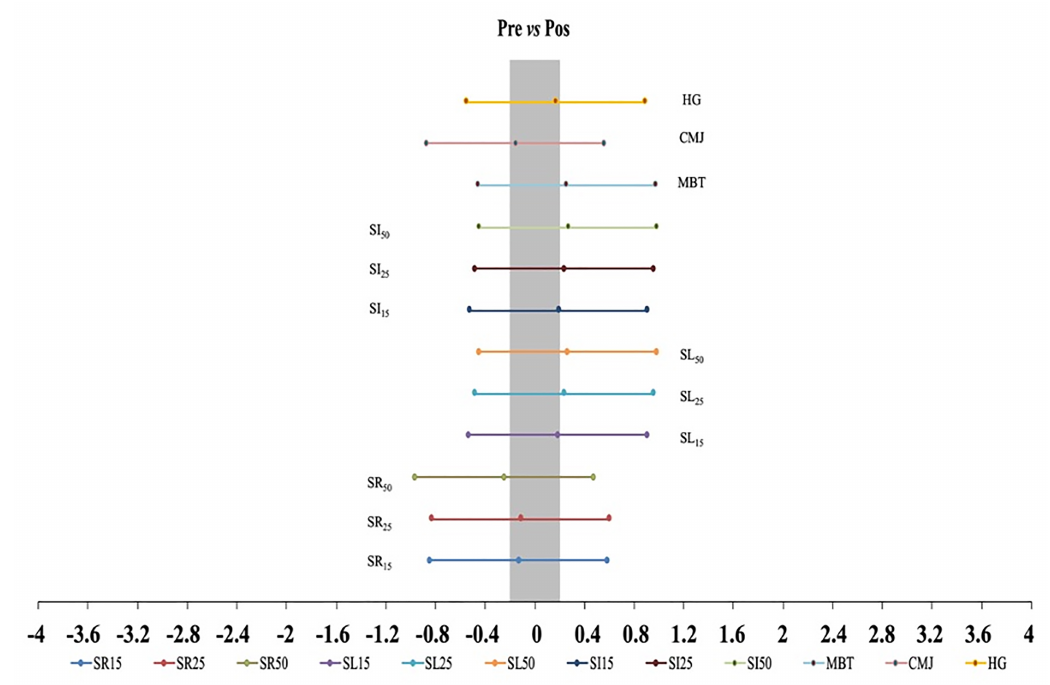
Fig. 1. Swimming kinematic and dry-land power variables effect size between pretest and posttest. SR, stroke rate; SL, stroke length; SI, stroke index; MBT, 3 kg medicine ball throwing; CMJ, countermovement jump; HG, handgrip. 15, 25 and 50 represent swimming distance.